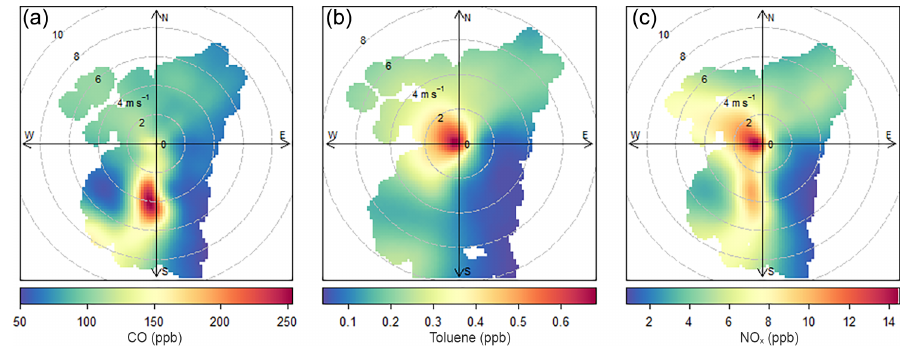
Figure 5. Bivariate polar plots showing how mole fractions (ppb) of (a) CO, (b) toluene and (c) NO x vary as a function of wind speed (ms − 1 ) and wind direction at the main MUMBA site during the campaign. Wind speed is represented by the concentric circles, and wind direction is shown as compass directions, such that the shape of the coloured area illustrates the wind speeds and directions experienced during the campaign. The colour indicates the mean mole fraction measured under the corresponding wind